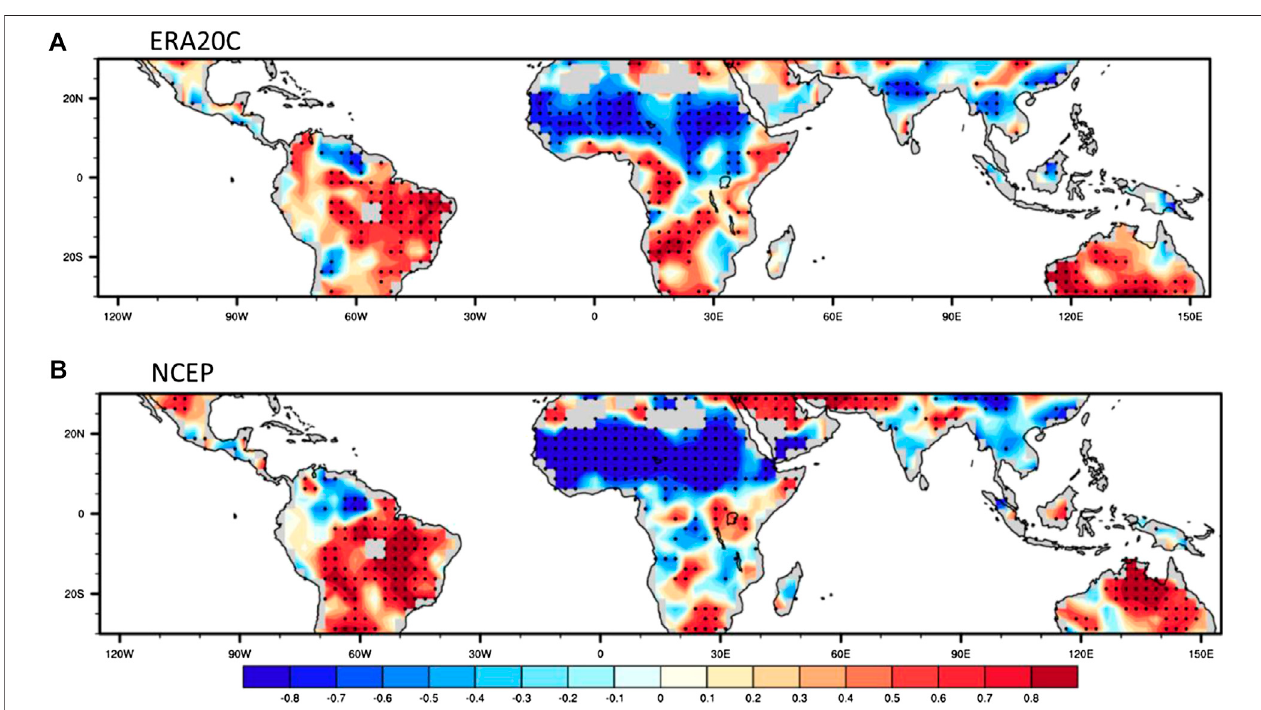
FIGURE4| CorrelationmapbetweenthedecadalcomponentoftheHCstrengthseesawindexandthetropicalprecipitation(30 ° S – 30 ° N).TheHCstrengthseesaw indexisderivedfrom (A) ERA20Cfortheperiod 1901 – 2010and (B) NCEPdatafortheperiod 1948 – 2013.TheprecipitationdataisderivedfromCRUdatafrom1901to 2013. The long-term linear trends were removed before the analysis. Dotted shading indicates the correlation coef fi cients signi fi cant at the 95% con fi dence level.